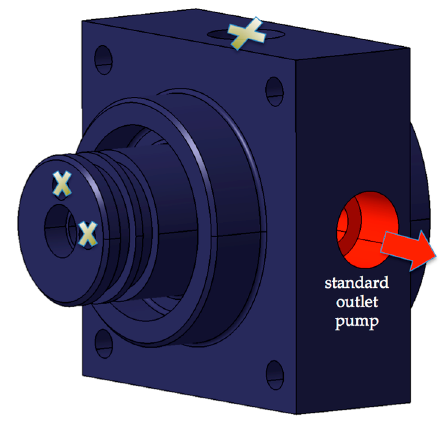
Figure 15. Standard outlet port configuration. Energies 2017 , 10 , 1458